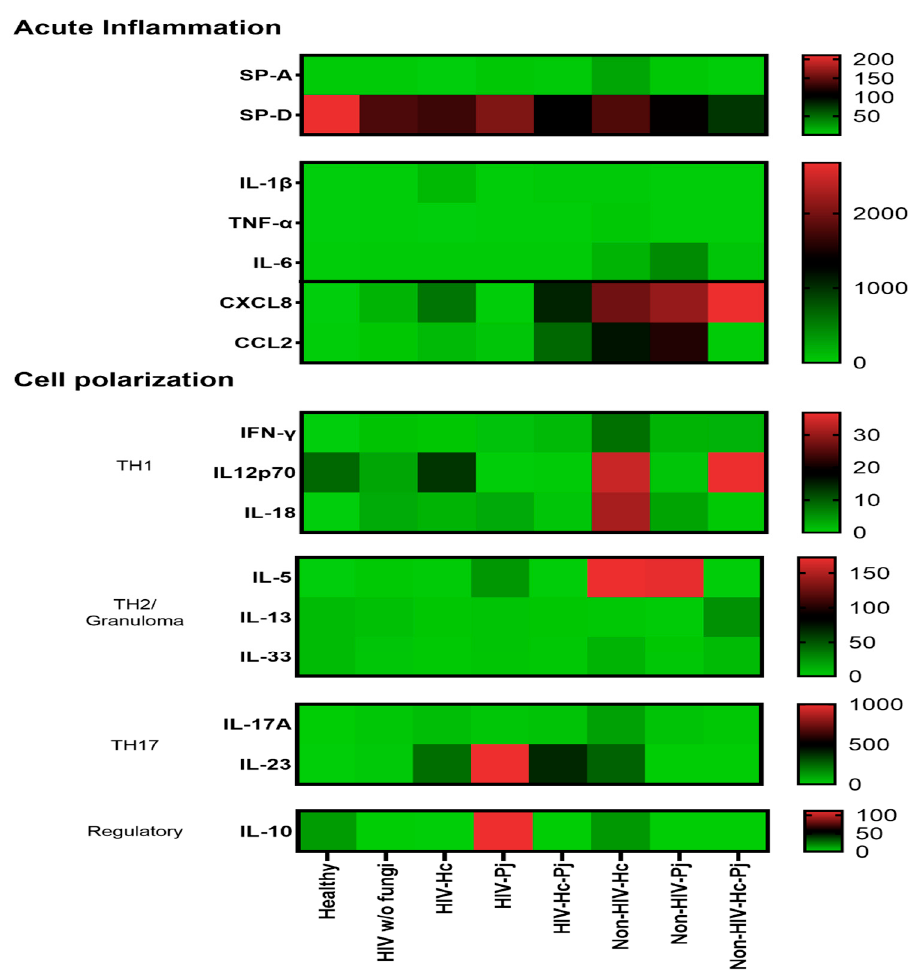
Figure 9. Heatmap of inflammatory mediators in H. capsulatum and P. jirovecii infections and their co-infection. Molecules were classified according to their primary immune function. Surfactant proteins and cytokines were clustered for the healthy control group, for each individual infection ( H. capsulatum and P. jirovecii ) and for co-infection. The heatmap shows the median concentration of each molecule per analyzed group; the scale is depicted at the right side of each module. Surfactant proteins were expressed in ng/mL and cytokines in pg/mL.